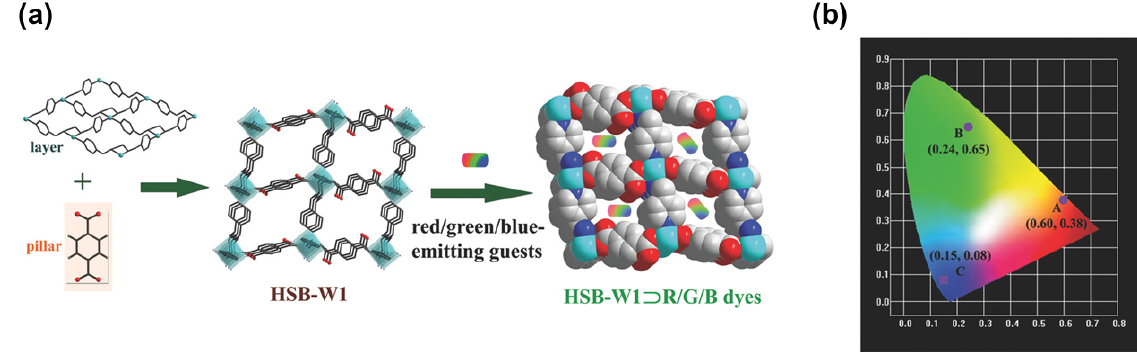
Figure 4. ( a ) Schematic synthesis of HSB-W1 ⊃ R/G/B Dyes. ( b ) The CIE coordinates of HSB-W1 ⊃ DCM (DCM, 0.31 wt%), HSB-W1 ⊃ C6 (C6, 0.04 wt%), and HSB-W1 ⊃ CBS-127 (CBS-127, 0.03 wt%) ( λ ex = 365 nm). (Reproduced with permission from ref. [51]. Copyright © 2019 Wiley—VCH Verlag GmbH & Co. KGaA,